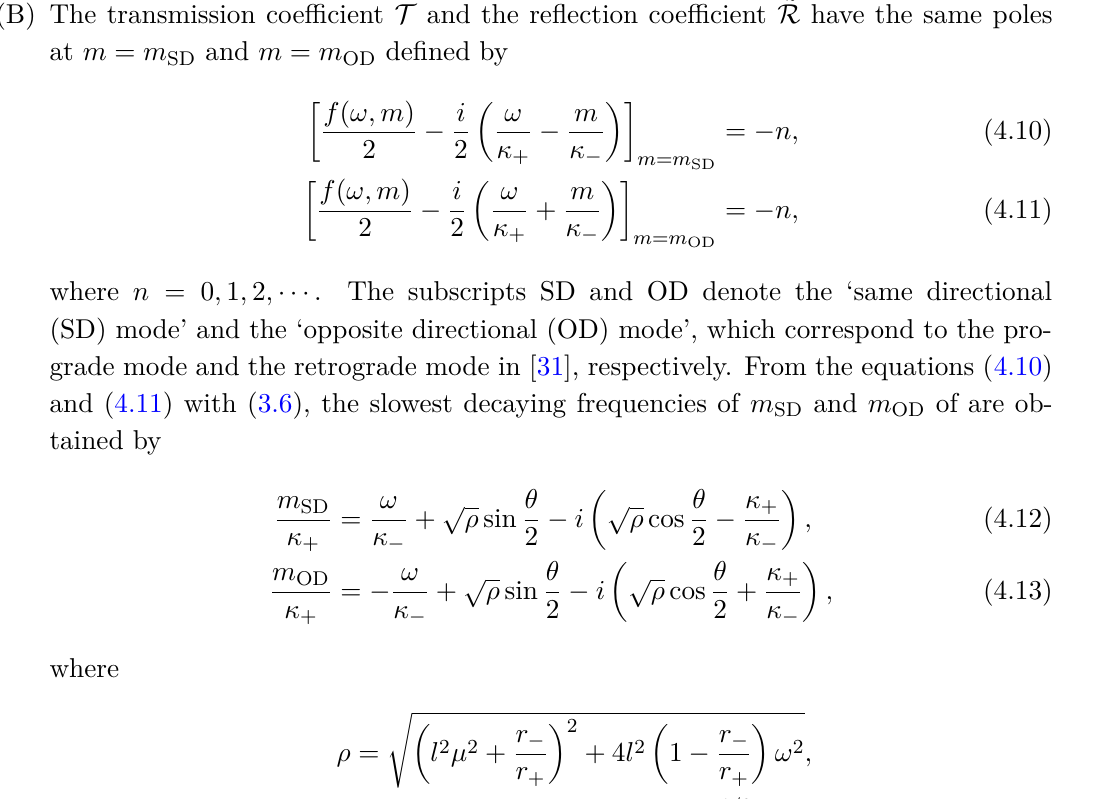
Figure 2 . The blue wavepacket (1) comes out from H + with profile Z and is reflected into L CH + . The green wavepacket (2) comes out from H − with profile X and is reflected into H + R R transmitted into CH + . The red wavepacket (3) comes in from I − with profile ˜ χ and is transmitted R into H + and transmitted into CH + R R